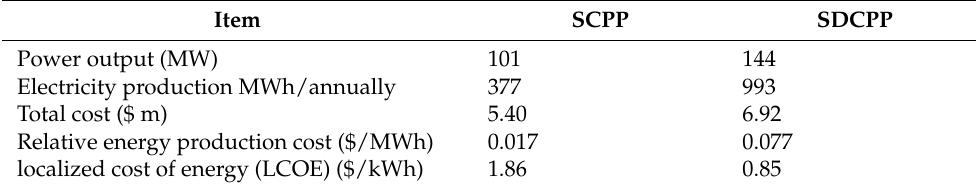
Table 6. Cost analysis of the traditional SCPP and the SDCPP